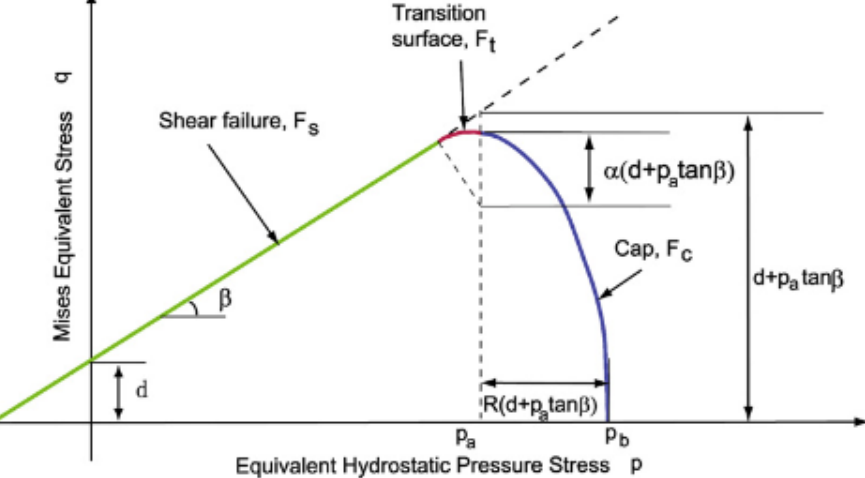
Figure 2. Drucker-Prager Cap model: yield surface in the p – q plane [23]. The model contains Drucker-Prager failure line defined as F S , Cap surface F C and